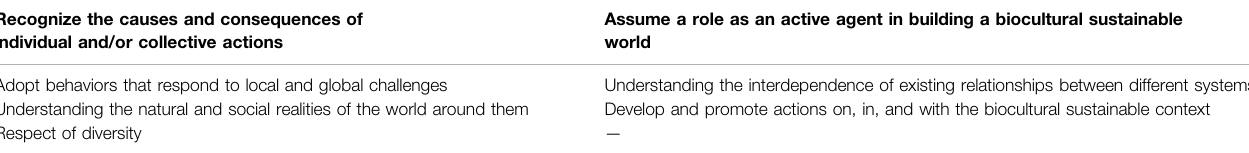
TABLE 7 | Main learnings to be developed by children about biocultural diversity and sustainable